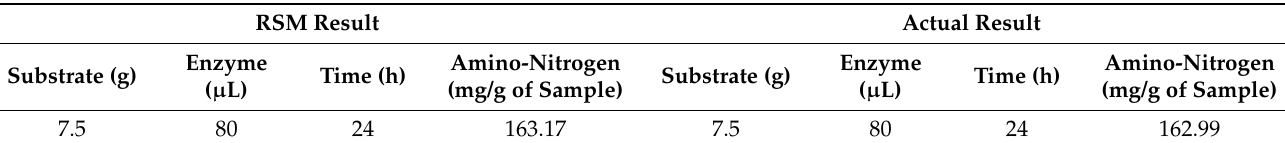
Table 1. Comparison of RSM and actual results.